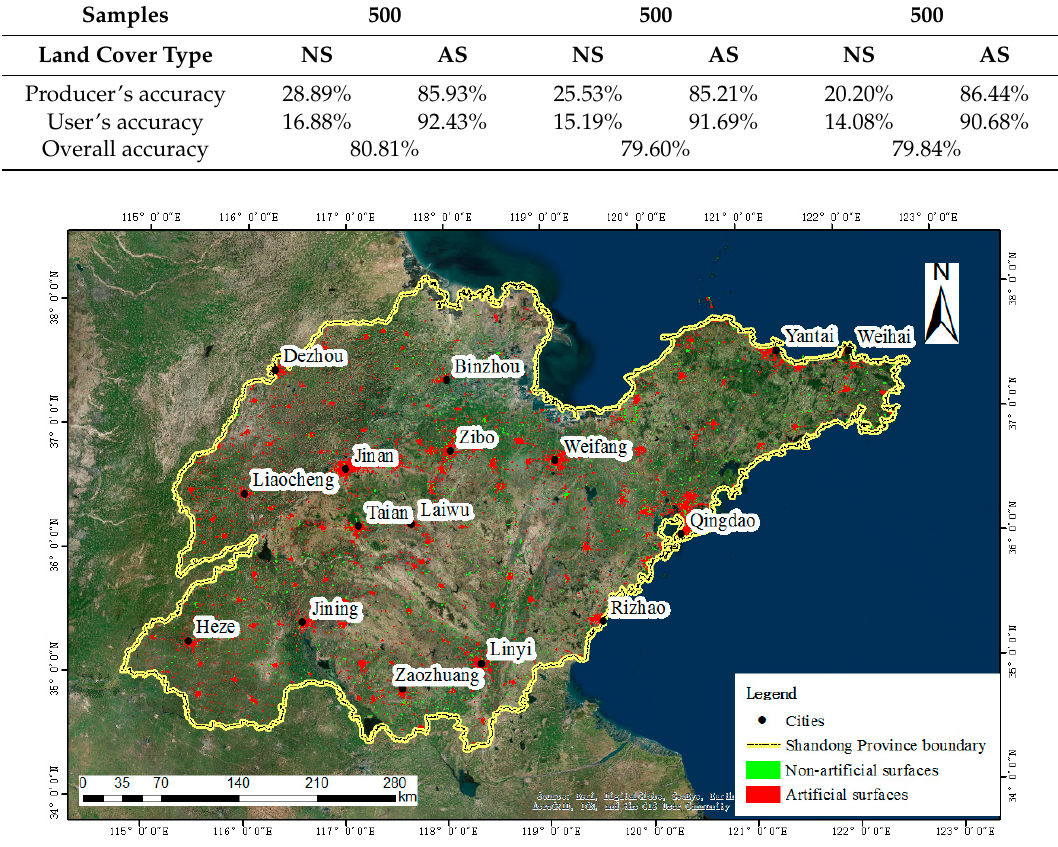
Figure 13. Land cover classification in Shandong.